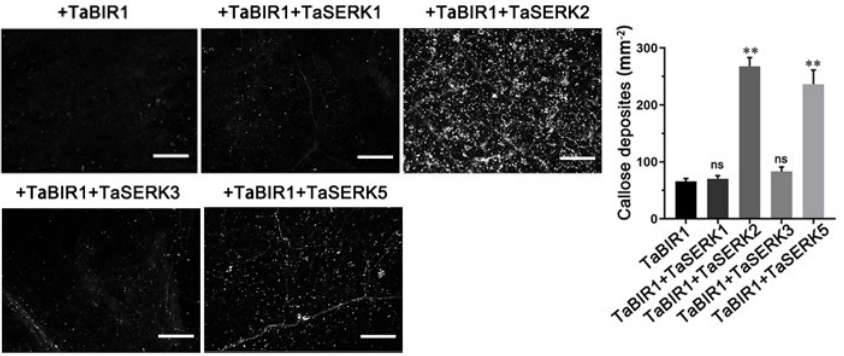
Figure 8. Heterologous expression of TaSERK2 and TaSERK5 restored the immunity triggered by TaBIR1 in NbBAK1 -silenced N. benthamiana leaves. Two weeks after inoculation of TRV2: NbBAK1 , TaSERKs and TaBIR1 were co-expressed in the corresponding plant leaves. Forty-eight hours later, the leaves were collected for aniline blue staining. The number of callose deposits per mm 2 in NbBAK1 -silenced leaves co-expressing TaSERKs and TaBIR1 was quantified. Values represent the